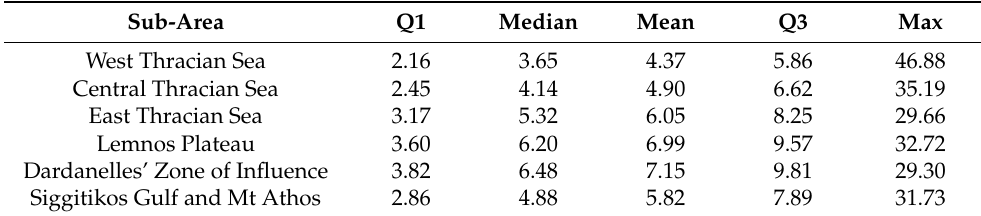
Table 1. Descriptive wind statistics in (m/s) at hub height (93 m), per study sub-area.